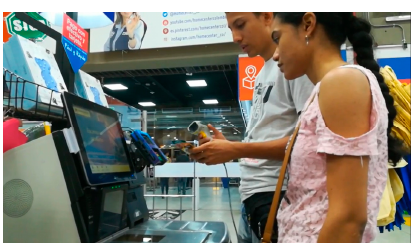
Figure 1. Observations and note-taking performed in a shopping center in Cali, Colombia. 5.